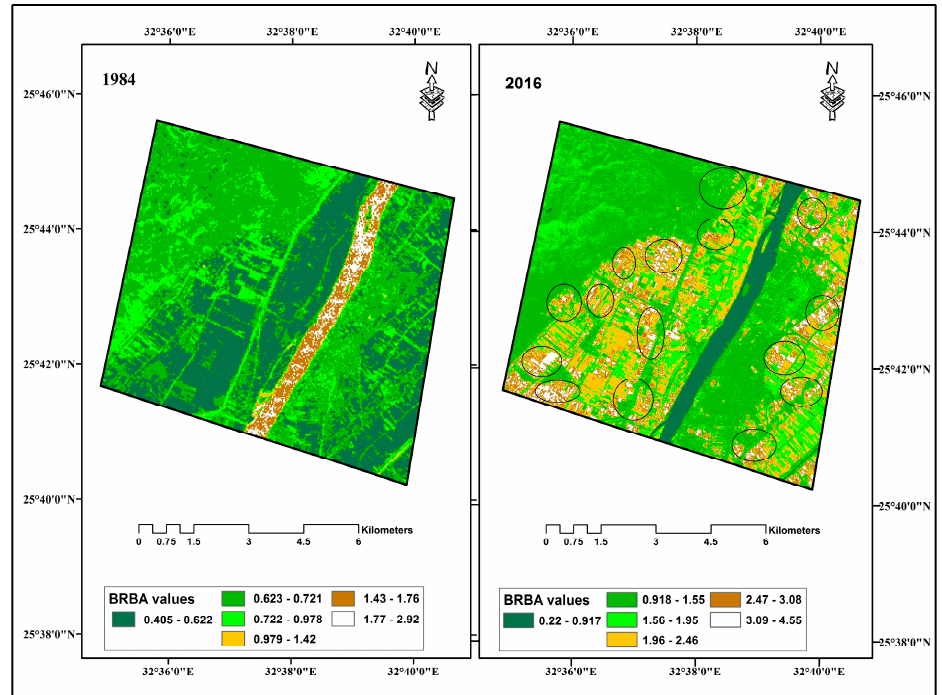
Figure 14. The changes in Band Rotation for Built up Area (BRBA) indices in the area between 1984 and 2016.